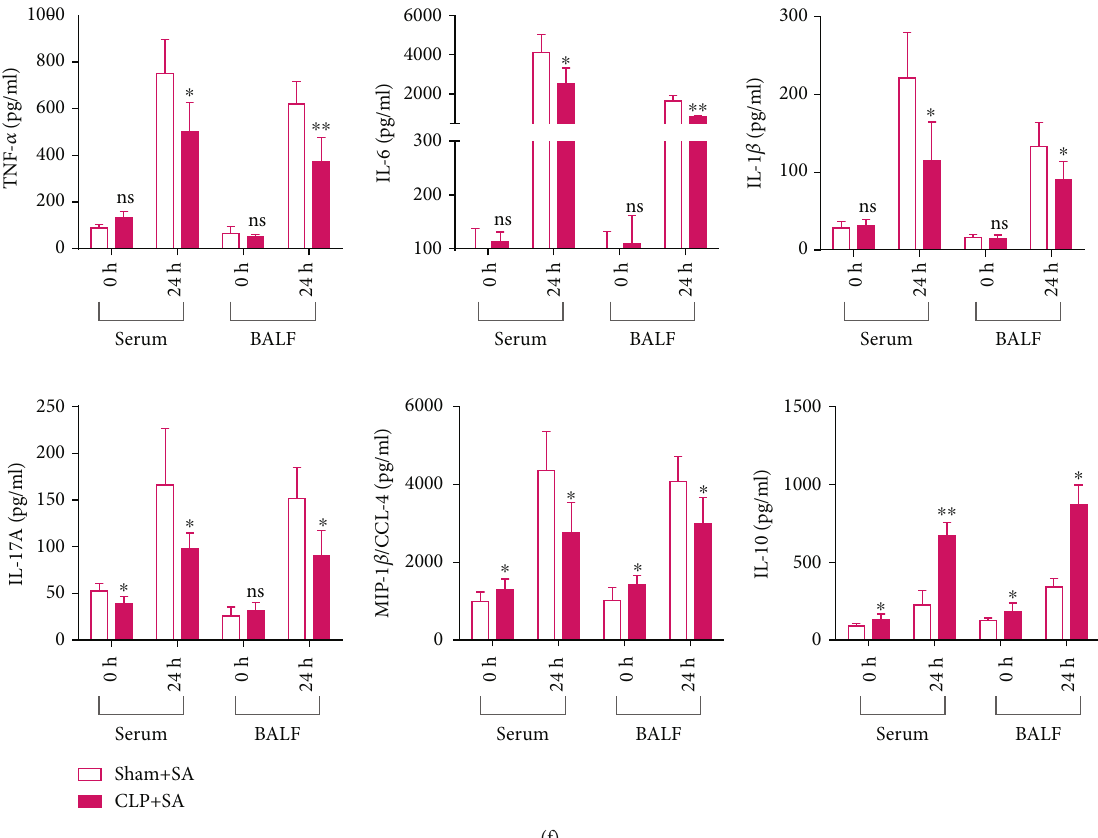
Figure 2: CLP led to damaged pulmonary immune responses in the host. Mice receiving CLP or sham operation. (a, b) Histological scores for CLP-induced nonsevere sepsis model ( n = 5 mice/group). (c, d) At 24 h and 72 h after CLP, we detected contents of cytokines in serum and BALF. Mice Cytokine Magnetic Bead Panel Kit ( n = 5 for every group) was performed to analyze the obtained specimens. (e) 72h after CLP, mice were given intratracheal injection with S. aureus ( 5 × 10 7 CFU). Following challenge ( n = 15 for every group), we observed mortality rates over the 10-day period. Log-rank (Mantel-Cox) test was performed to analyze survival curves. (f) At 24 h following secondary infection with S. aureus , we detected contents of chemokines and cytokines in serum and BALF. Mice Cytokine Magnetic Bead Panel Kit ( n = 5 for every group) was performed to analyze the obtained specimens. Values were presented in the manner of mean ± SD , whereas nonparametric Mann – Whitney U test was adopted for data analysis. ∗ p < 0 : 05 , ∗∗ p < 0 : 01 , compared with normal control or sham- surgery mice upon secondary S. aureus